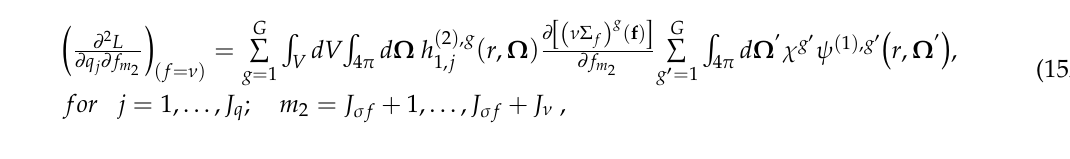
(cid:18) (cid:19) q j , σ g , j = 2,4,6,8,10,12 ; k = 1,2; g = 1, ... ,30, for 2nd-order f , k